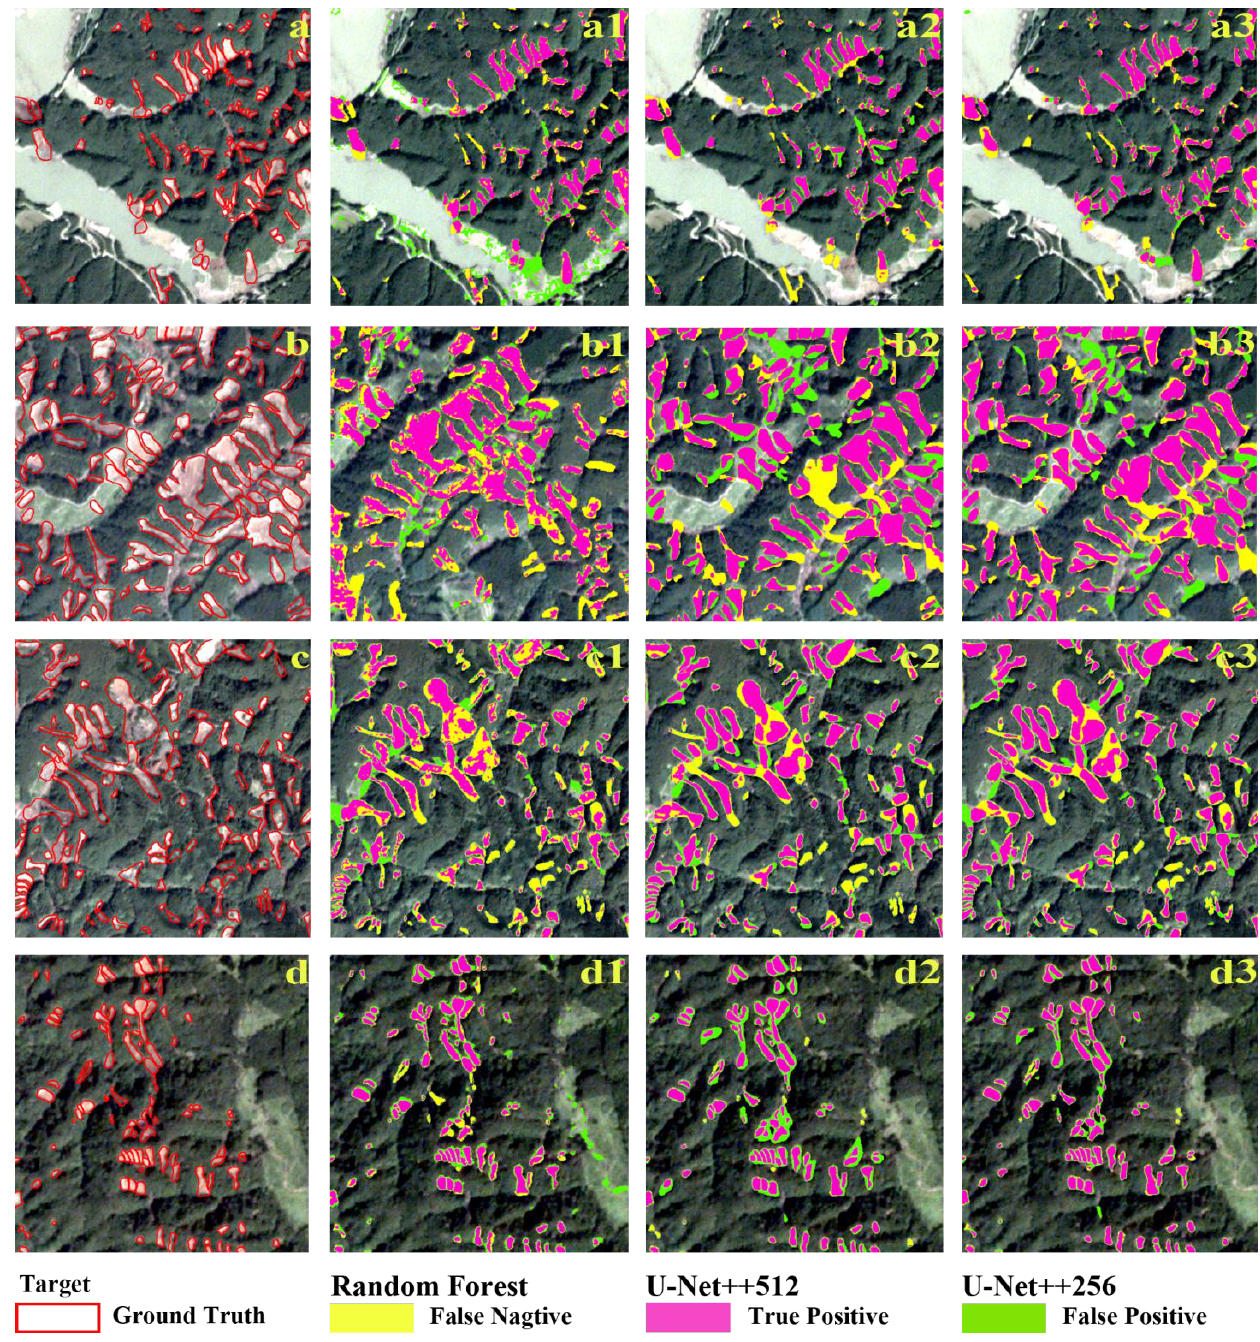
Figure 12. Visualization of the confusion matrix. ( a – d ) Planet image with ground truth of landslides (red boundary polygons), identified landslides (peach polygons) by RF ( a1 – d1 ), U − Net++512 ( a2 – d2 ), and U − Net++256 ( a3 – d3 ). The yellow and green parts represent FN and FP, respectively.